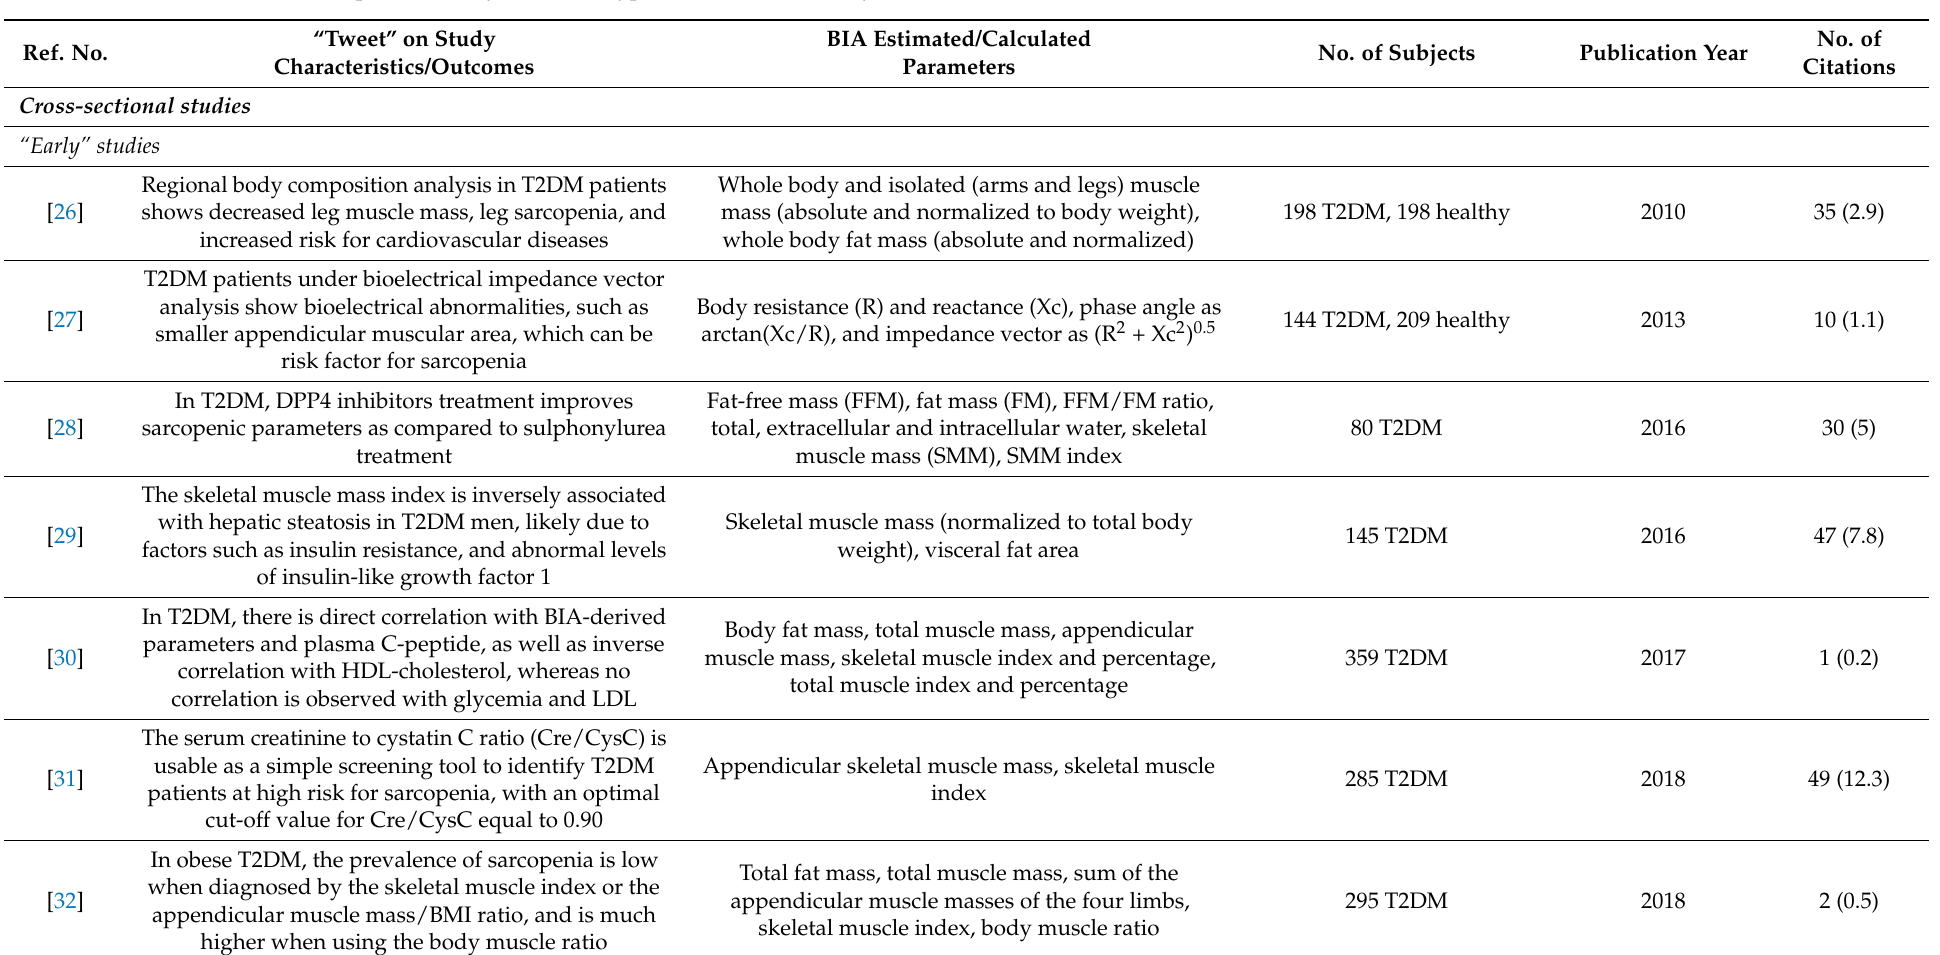
Table 1. Main characteristics and information on analyzed studies. Each “Tweet” is 200 characters max. Number of citations (SCOPUS): last check: 4 March 2022; in parentheses: number of citations per year. No. of subjects field specifies the number of T2DM subjects and possibly of other populations, if any. BIA: bioelectric impedance analysis; T2DM: type 2 diabetes; BMI: body mass